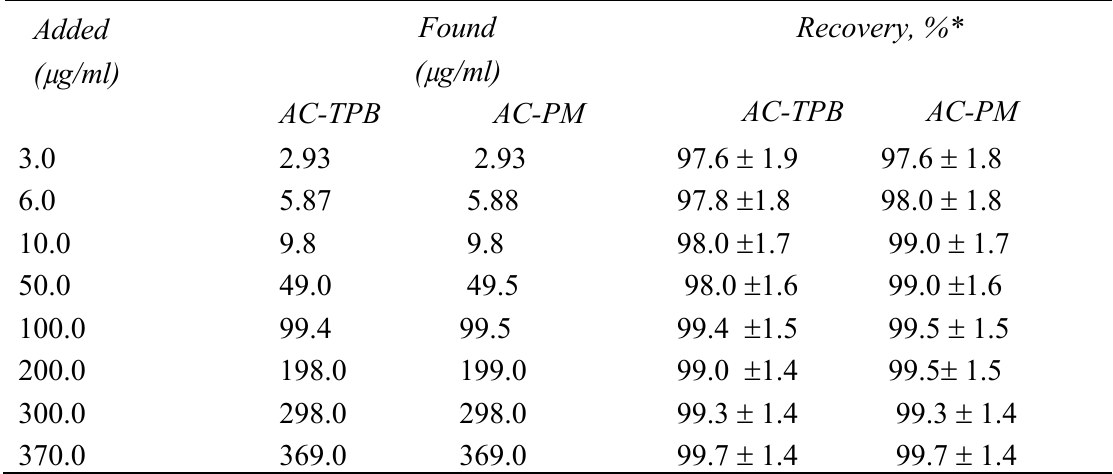
Table. 4. Direct determinations of the percentage recovery of AC using the proposed PVC membrane